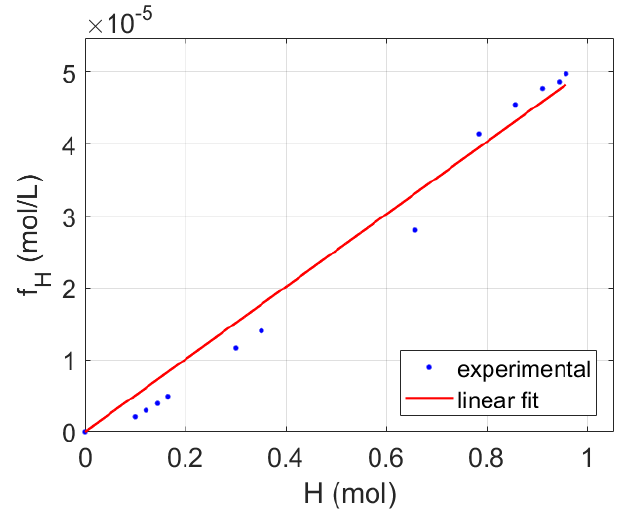
Figure 4. Linear fit of f H function vs. cumulative hydrogen production for the experiment shown in Figure 1.